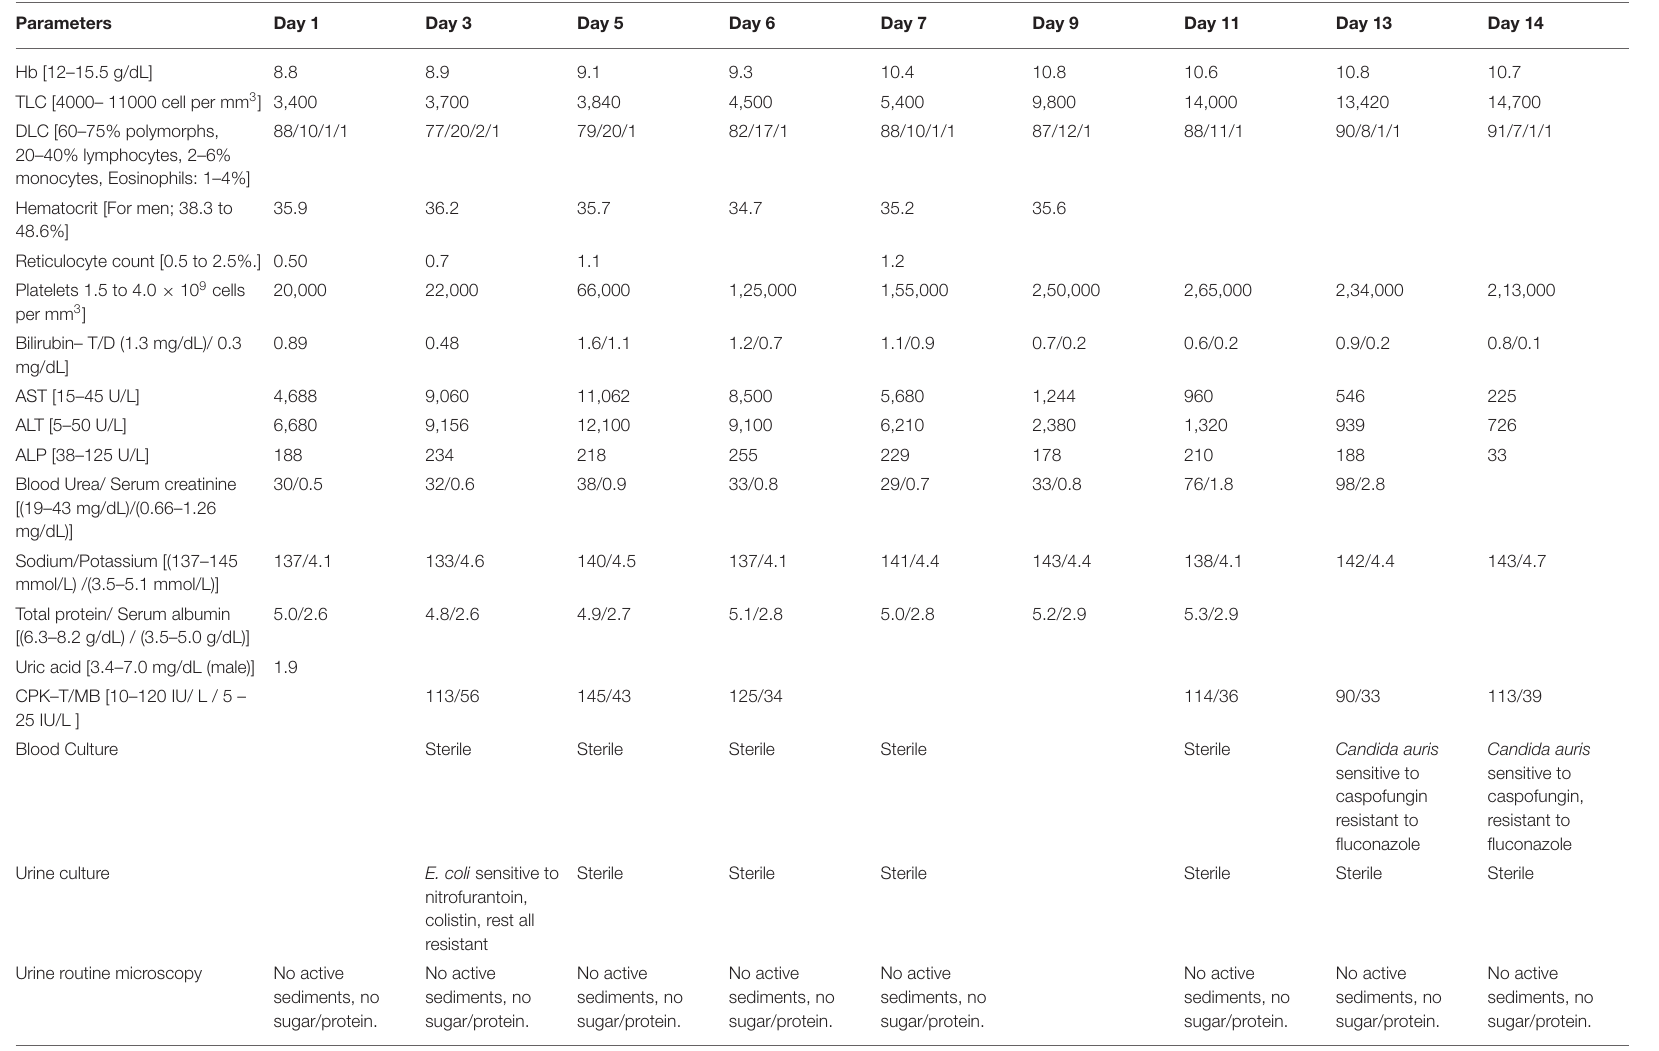
TABLE 1 | Showing laboratory parameters during the current hospital stay.